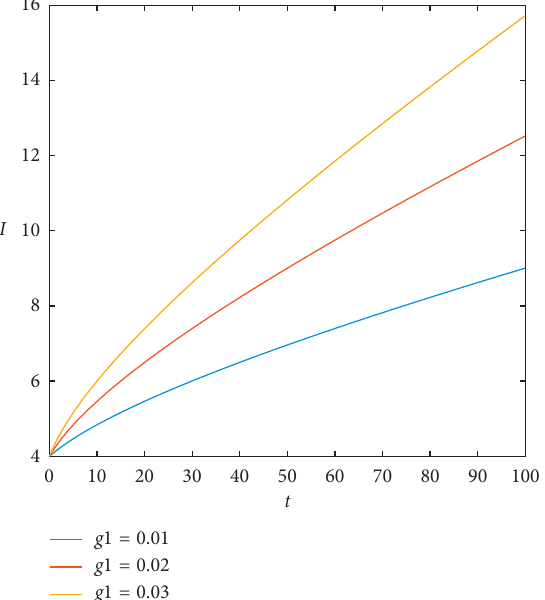
Figure 3: Sensitivity analysis of investment in pollution abatement.